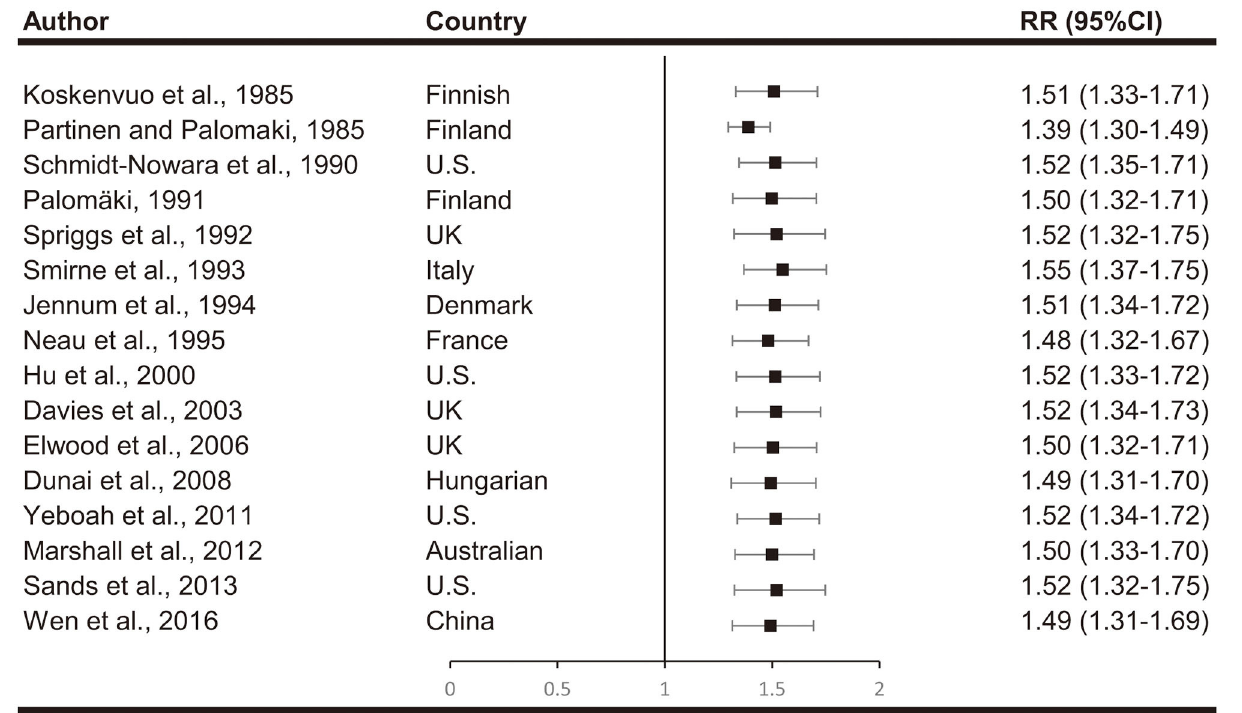
FIGURE 4 | Sensitivity analyses by omitting one study at a